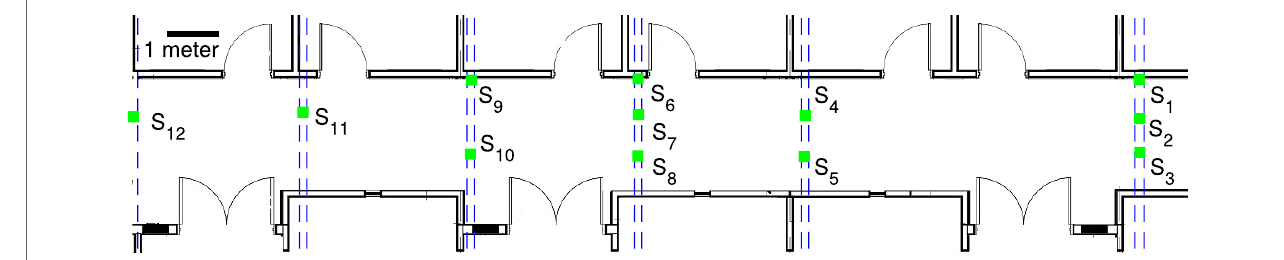
FIGURE 6 | The test area in Goodwin hall on the campus of Virginia Tech. The pairs of dashed lines ( == ) show the outlines of steel girders that have mounted sensors active in this study, and square symbols (cid:4) S 1 , ::: , (cid:4) S 12 , mark the sensor locations on the girders.